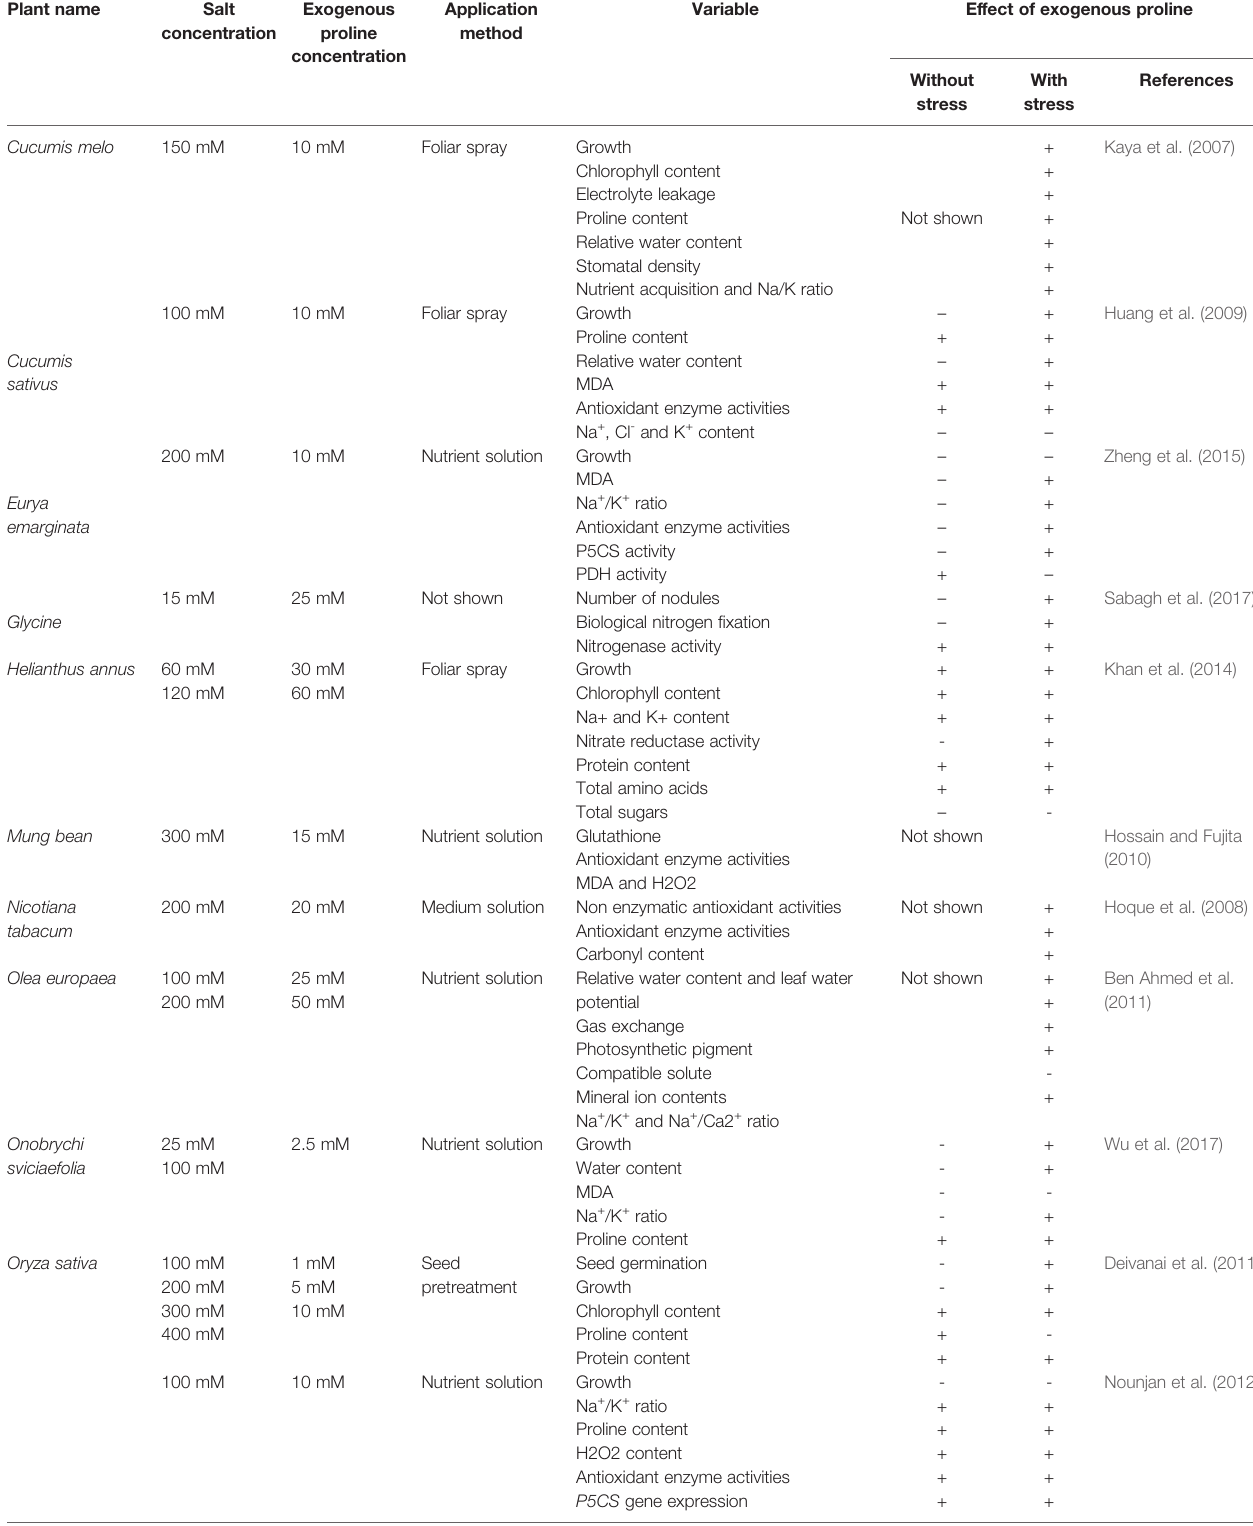
TABLE 1 | Effects of exogenous proline on seed germination, plant growth, photosynthesis, nutrient acquisition, water uptake, ionic toxicity, proline metabolism, gene expression, antioxidant activities, and biological nitrogen fi xation in different plant species under salt